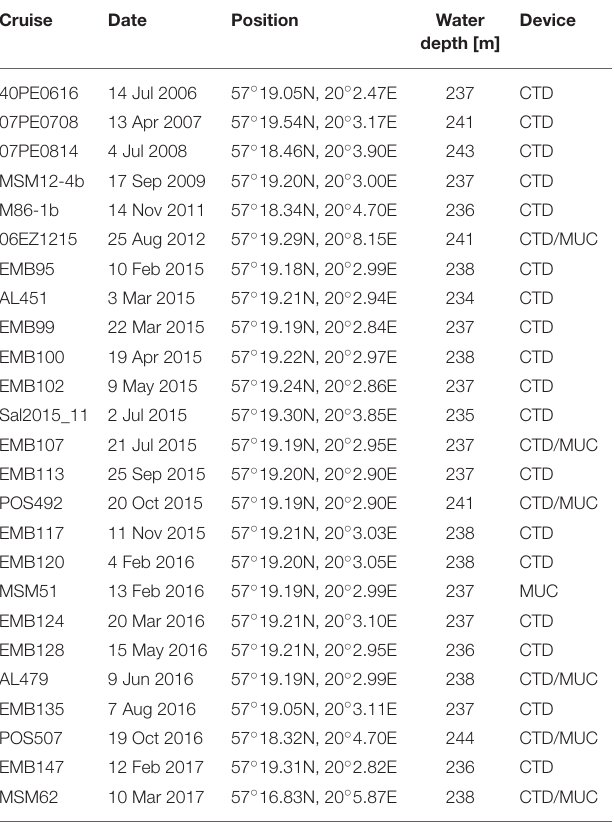
TABLE 1 | Cruises from which sample material was obtained close to the IOW monitoring station 271 (BY15), in the central Gotland Deep (PE = R/V Prof. Albrecht Penck , MSM = R/V Maria S. Merian , M = R/V Meteor , EZ/EMB = R/V Elisabeth Mann Borgese , AL = R/V Alkor , POS = R/V Poseidon , Sal = R/V Salme